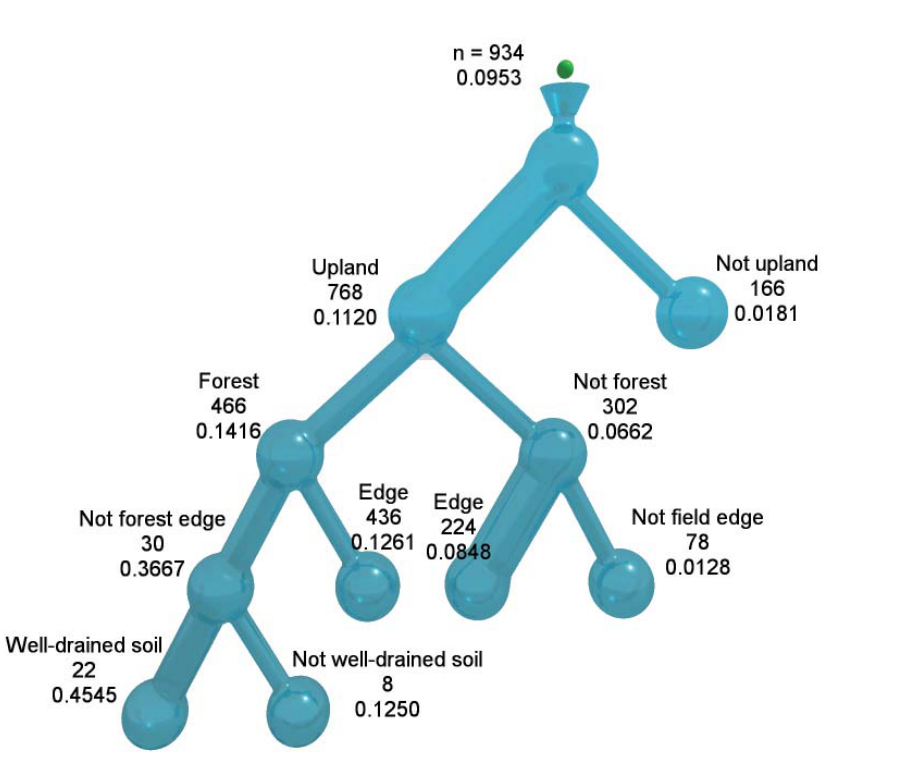
Figure 5. Final classification tree for locating areas likely to contain pignut hickory, the larval host tree of Urographis despectus . Numbers indicate group size (top number) and the probability that pignut hickory was present. Terminal nodes with yellow text indicate conditions used to determine the larval habitat maps. White text indicates interme- diate or terminal nodes that were not included in the final map. At each split the relative cross-sectional areas of the tubes are proportional to the difference in the probabilities at the next nodes that pignut hickory was present.